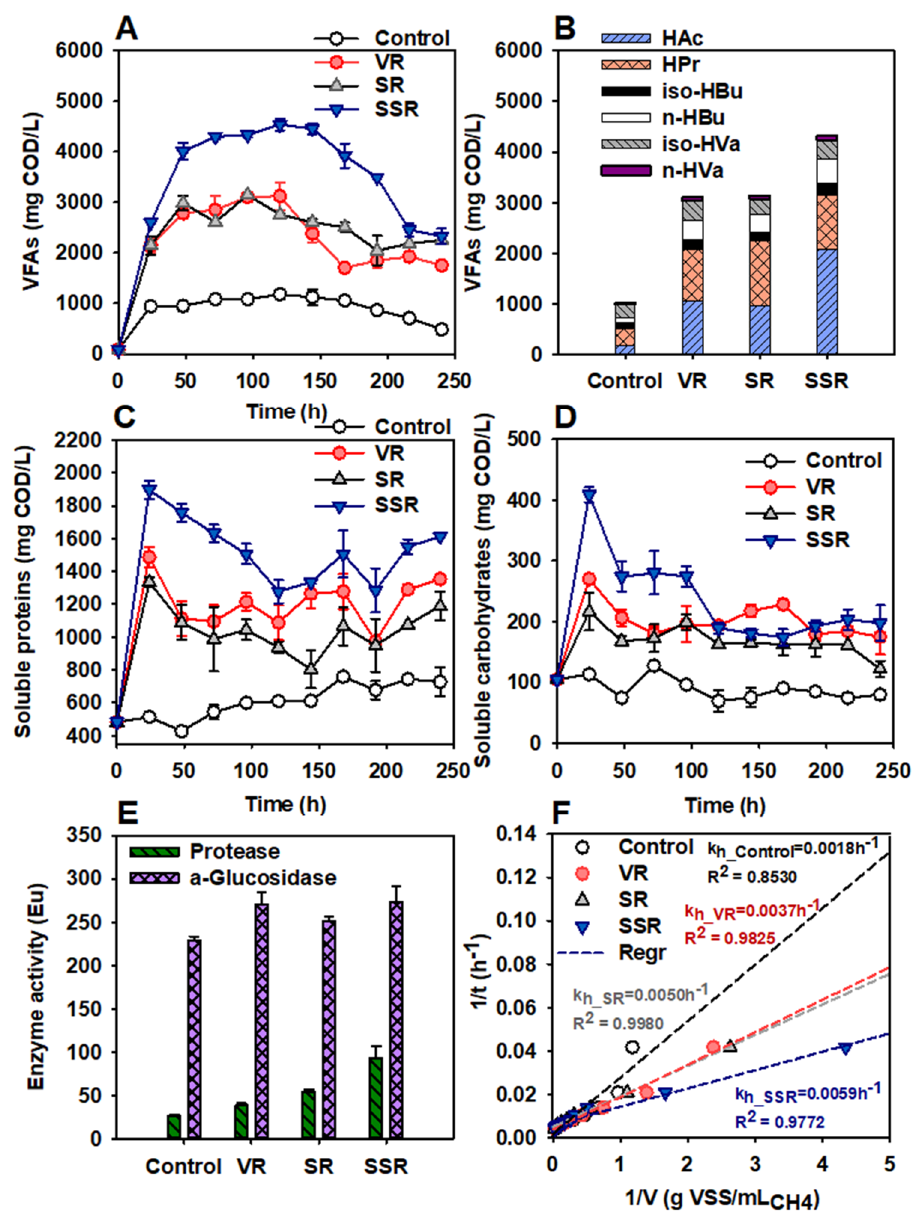
Figure 2. Fermentation performance with different feedstock, time-course profiles of VFAs concentration ( A ), VFAs composition on day 4 ( B ), soluble carbohydrates ( C ) and proteins ( D ) concentrations during WAS and PWs co-fermentation, hydrolytic enzyme activities on day 2 of anaerobic fermentation systems ( E ), calculation of k h using methane yield data for 240 h after feeding ( F ) (Note: error bars represent standard deviation).